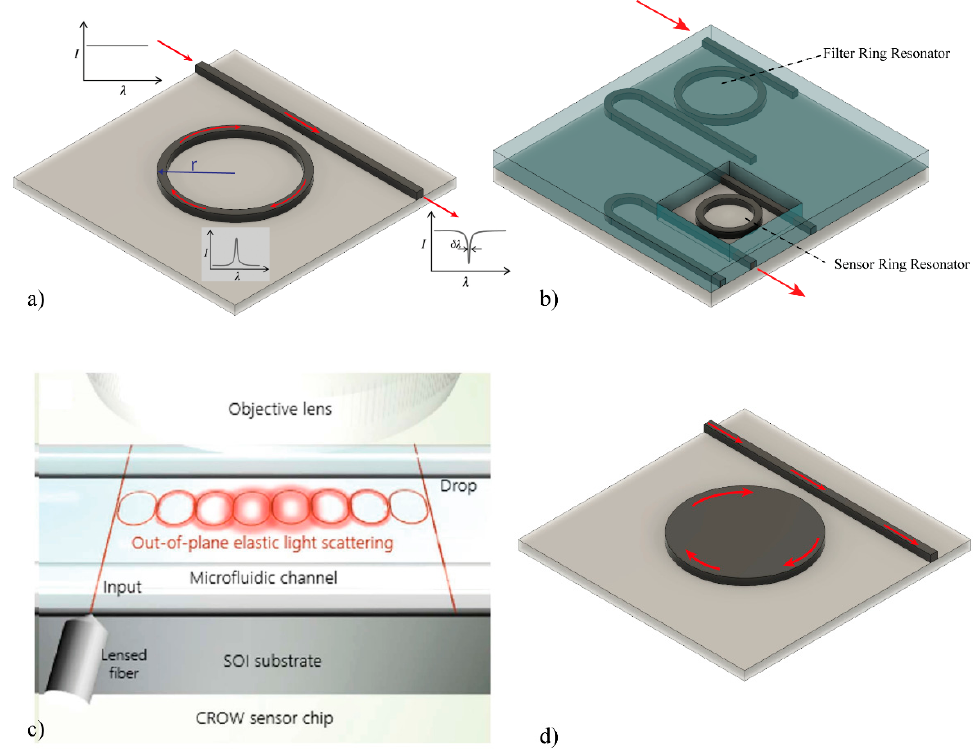
Figure 6. Ring resonator biosensors. ( a ) Conventional ring resonator; ( b ) two cascade ring resonators based on the Vernier-effect, which is redrawn based on [69]; ( c ) coupled-resonator optical-waveguide (CROW) [72] with permission of the Nature Publishing Group, and ( d ) micro-disk resonator [75].